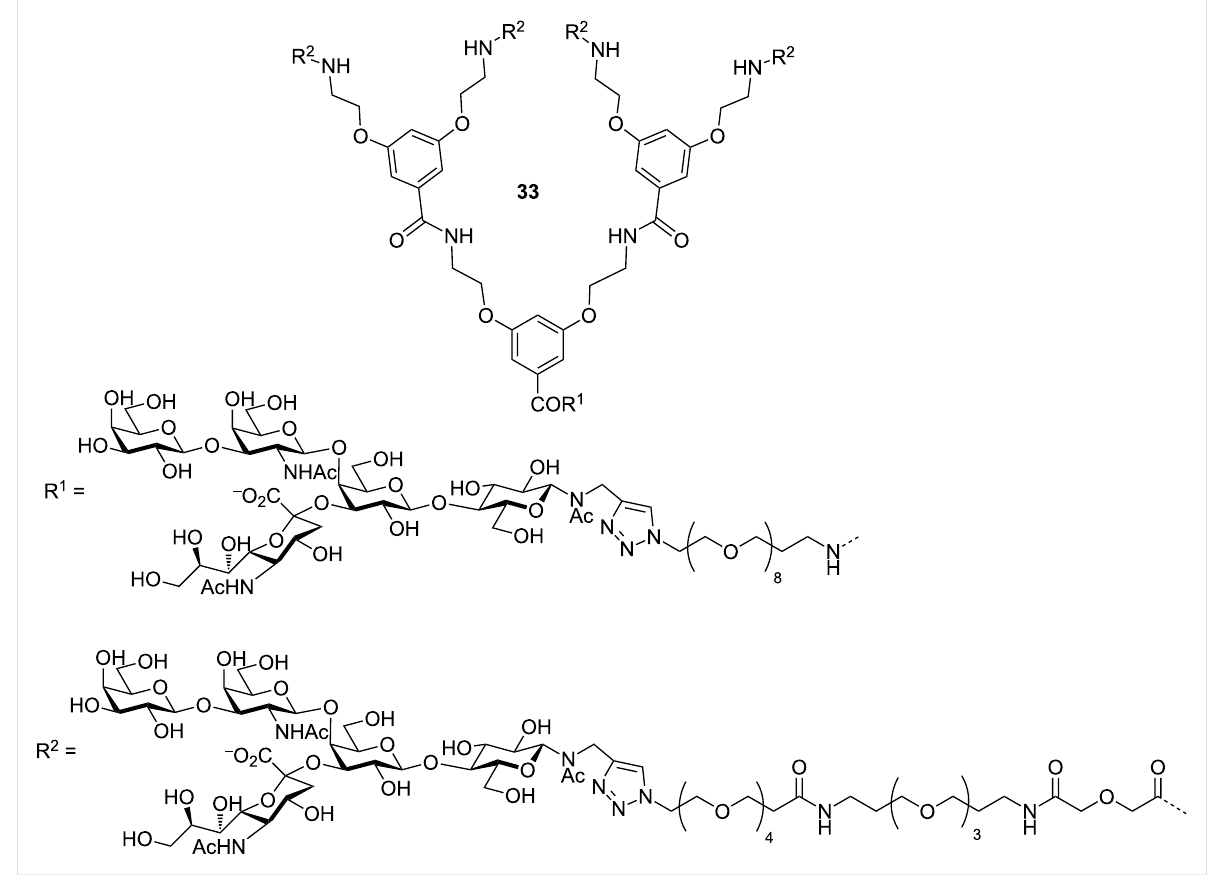
Figure 14: Pentavalent inhibitor designed by Pieters and co-workers.